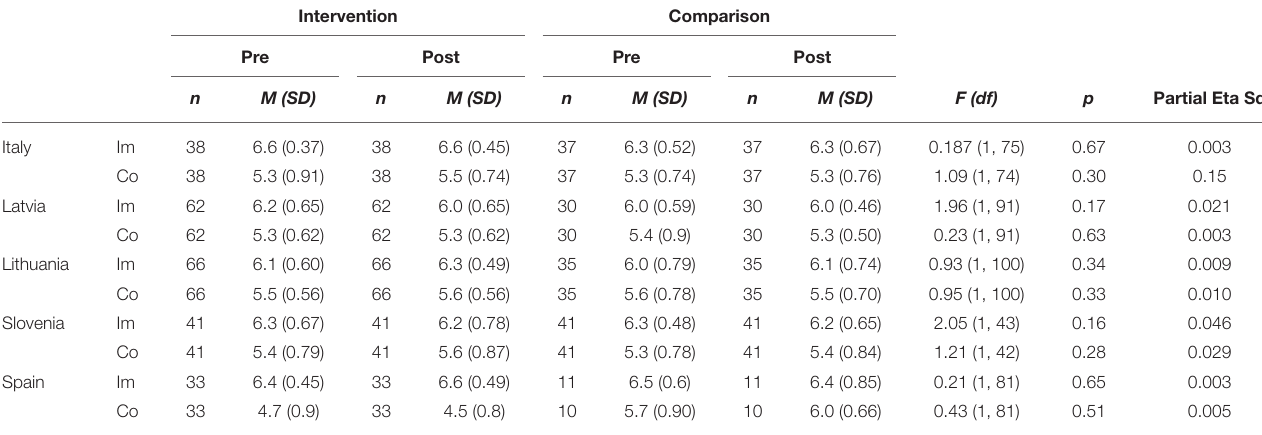
TABLE 5 | Teachers perceived importance and competence in SEL. Intervention